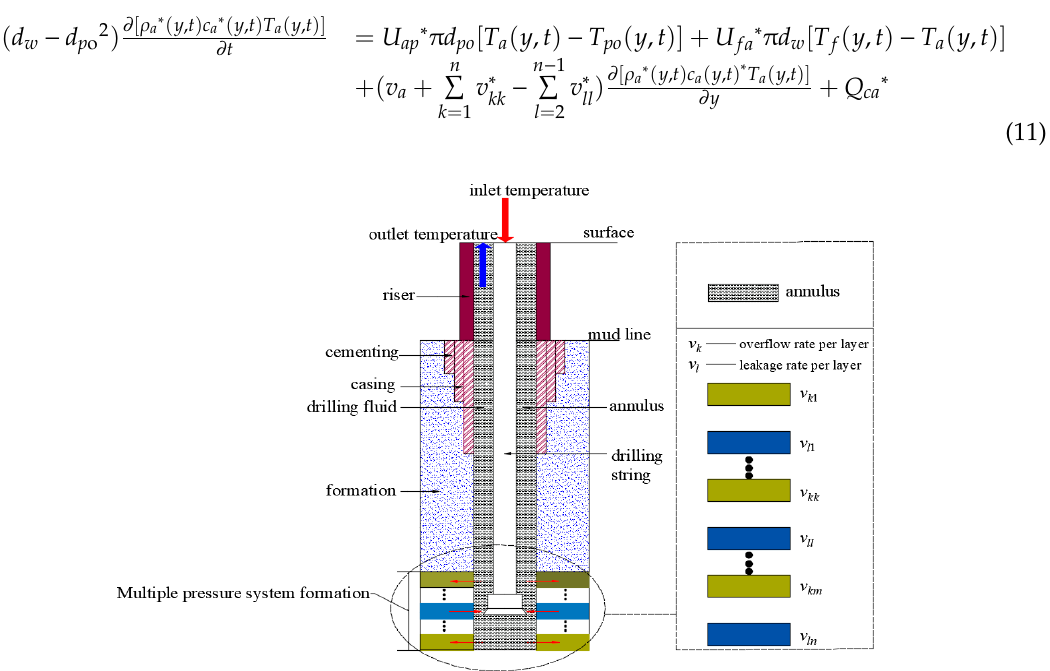
Figure 4. Physic model of multi-pressure system segment located at bottom hole.